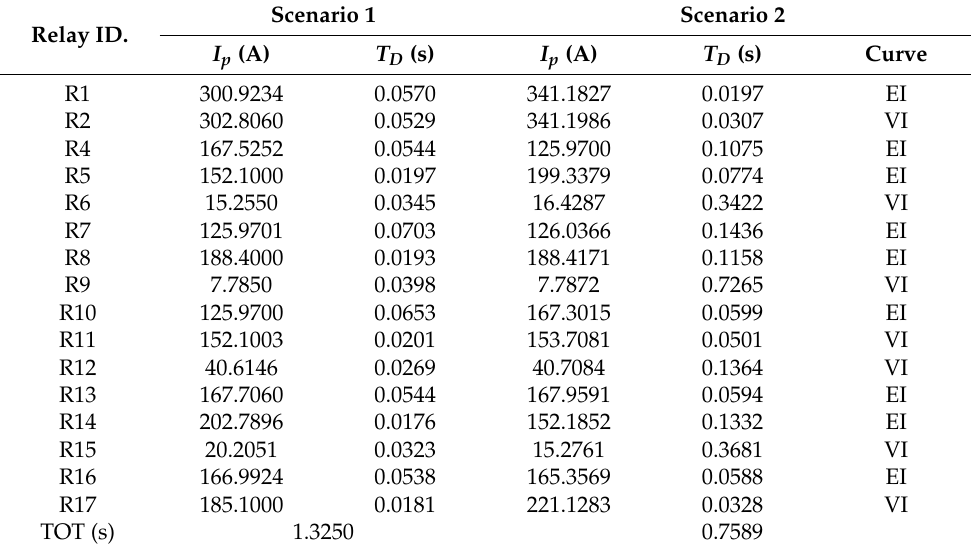
Table 10. OCRs optimum settings of Agiba network using Test Model 4. Relay ID.